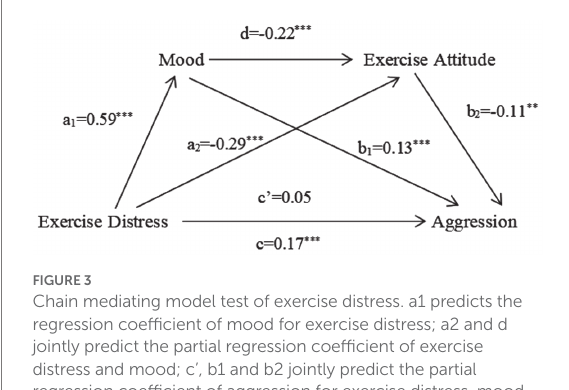
FIGURE 3 Chain mediating model test of exercise distress. a1 predicts the regression coefficient of mood for exercise distress; a2 and d jointly predict the partial regression coefficient of exercise distress and mood; c’, b1 and b2 jointly predict the partial regression coefficient of aggression for exercise distress, mood and exercise attitude; c indicates the regression coefficient of exercise distress to aggression without mediating variables.